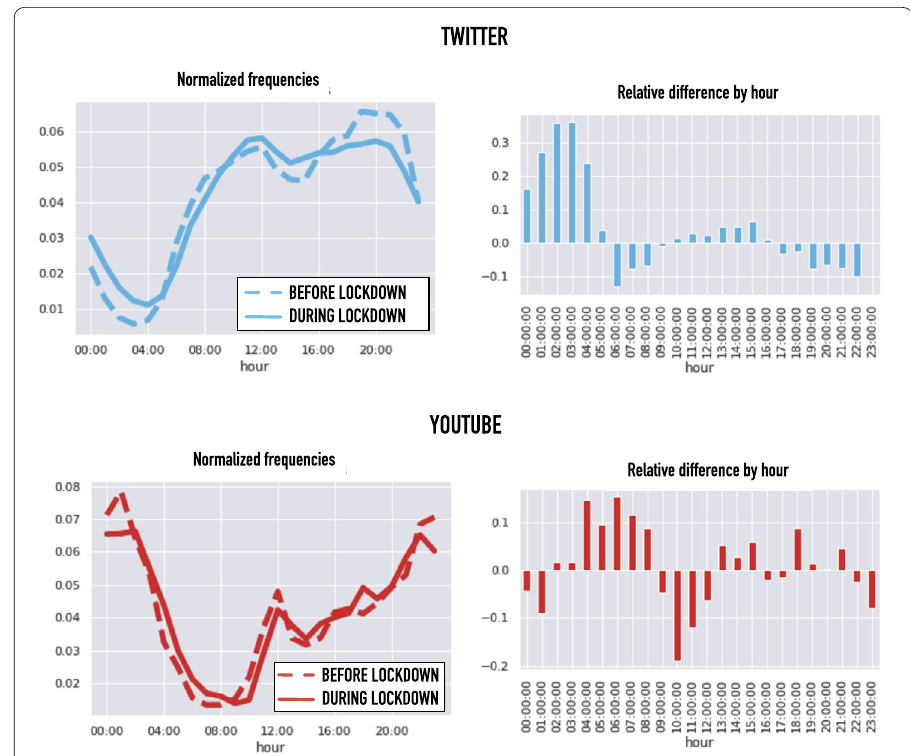
Figure 2 Circadian Rhythm Changes. On the left, Twitter and YouTube circadian rhythms before and after the lockdown. On the right, we explicitly evaluate the relative differences between rhythms before and after the